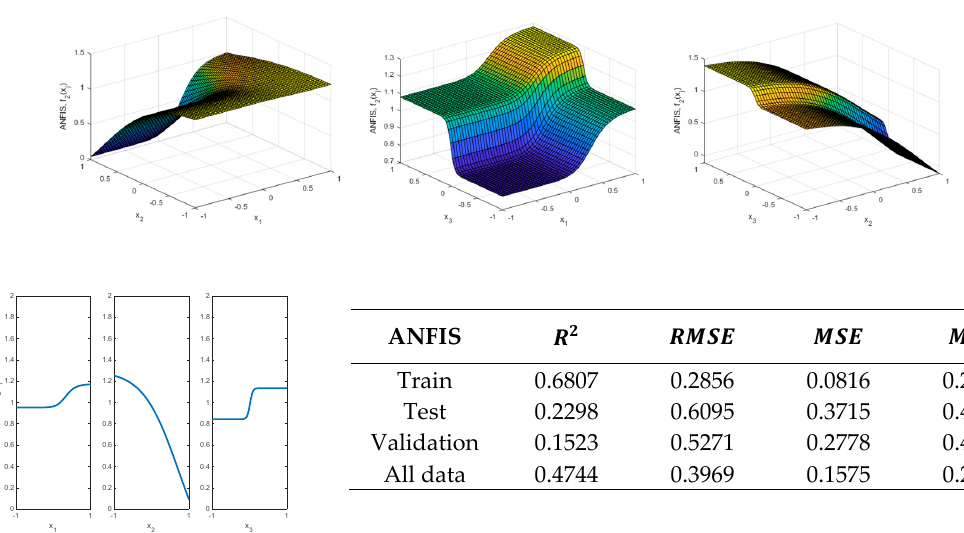
Figure 23. Response surface obtained with the zero-order Sugeno FIS employed for modeling f 2 using two Gaussian membership functions for the inputs along with an ANFIS (500 epochs, 8 fuzzy rules). If the membership functions are increased to three, a satisfactory result is not obtained either,